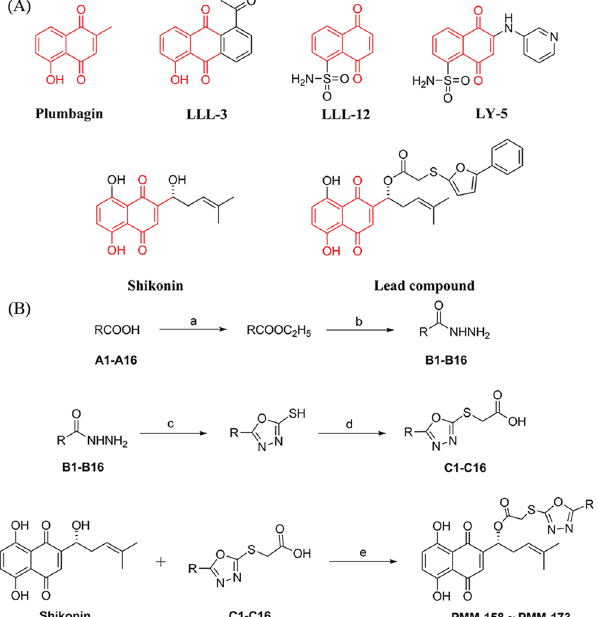
Figure 1. ( A ) Reported synthetic STAT3 inhibitors and SHK with lead compound. The analogous structure for these compounds is colored in red. ( B ) Synthesis of compounds PMM-158~PMM-173. Reagents and conditions: (a) concentrated sulfuric acid, ethanol, reflux, 24 h; (b) NH 2 NH 2 -H 2 O (85%), ethanol, reflux, 12 h; (c) (1) CS 2 /KOH, ethanol (95%), reflux, 24 h; (2) HCl, PH 5–6; (d) ClCH 2 COOH, ethanol, reflux, 12 h; (e) DCC, DMAP, CH 2 Cl 2 , 0 °C, 8